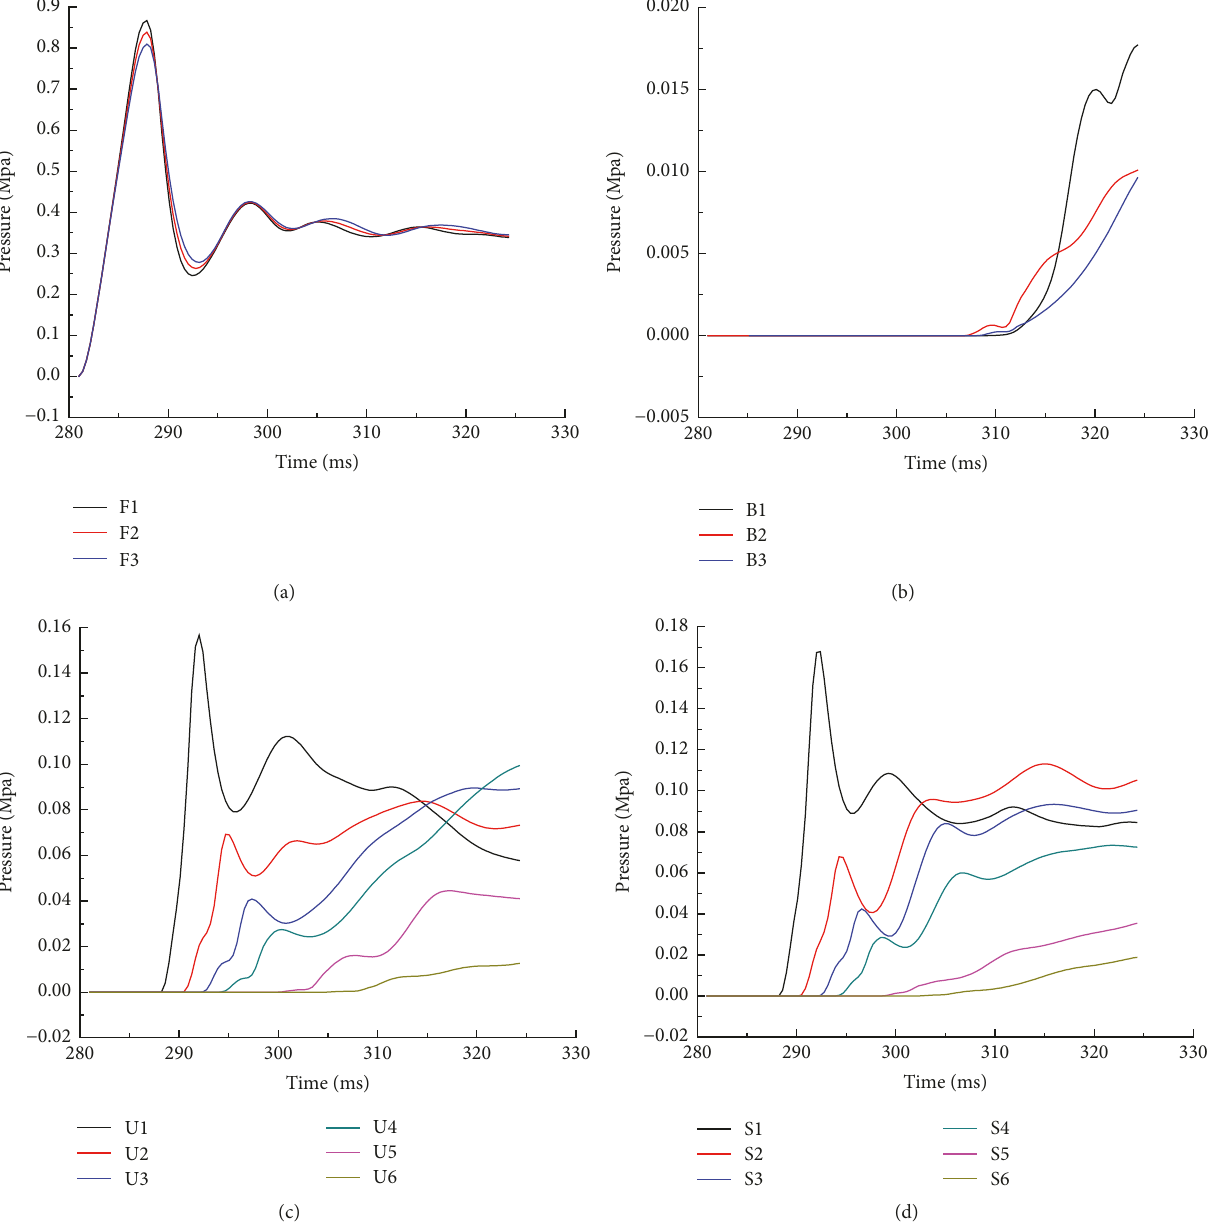
Figure 8: Pressure-time curve in positions on different